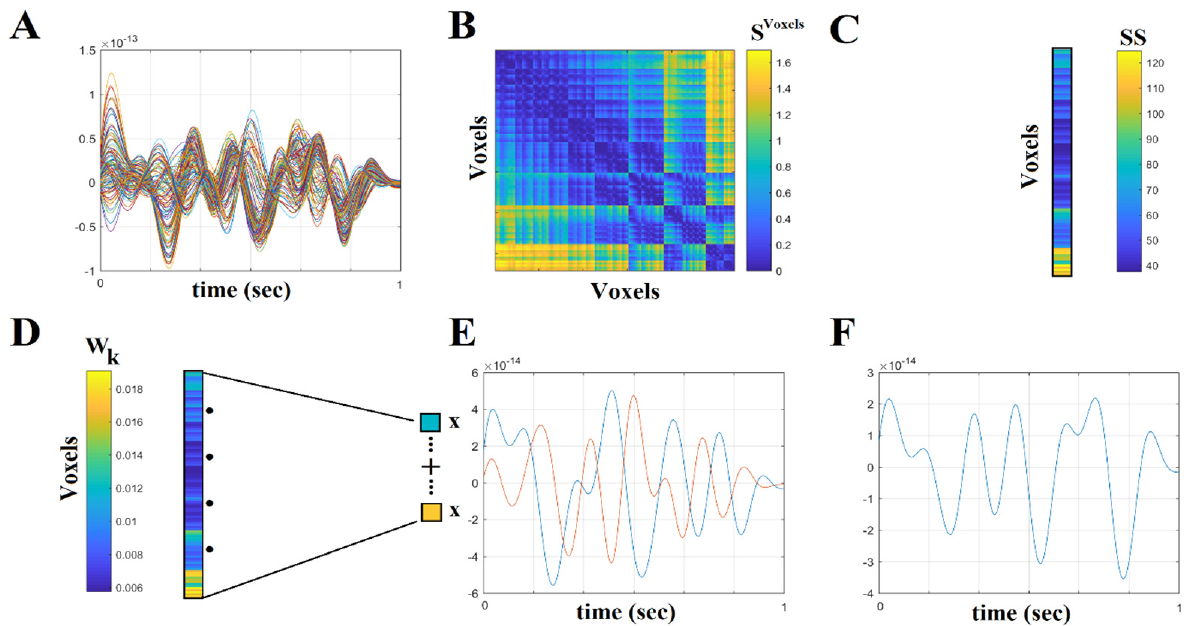
Figure 1. Step-by-step construction of the representative virtual sensor time series for each ROI. ( A ) The plot of the 108 voxel time series falls within the left precentral gyrus ROI. ( B ): Distance correla- tion matrix 𝑆 (cid:3023)(cid:3042)(cid:3051)(cid:3032)(cid:3039)(cid:3046) derived by the pairwise estimation of the 108 voxel time series. ( C ) Summation of the columns of 𝑆 (cid:3023)(cid:3042)(cid:3051)(cid:3032)(cid:3039)(cid:3046) produced the vector SS. ( D ) Normalisation of vector SS, which further produces W k , where its sum equals one. ( E ) Multiplication of every voxel time series by the related weight from the W k . In this example, we demonstrated this multiplication for the first and last voxel time series. ( F ) The estimated time series for left precentral gyrus activation ((ROI activity ) was obtained by summing the weighted versions of every voxel time series (as in ( E )).